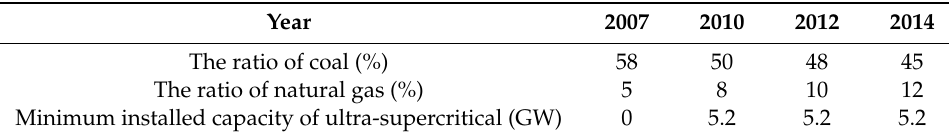
Table 1. Historical scenario